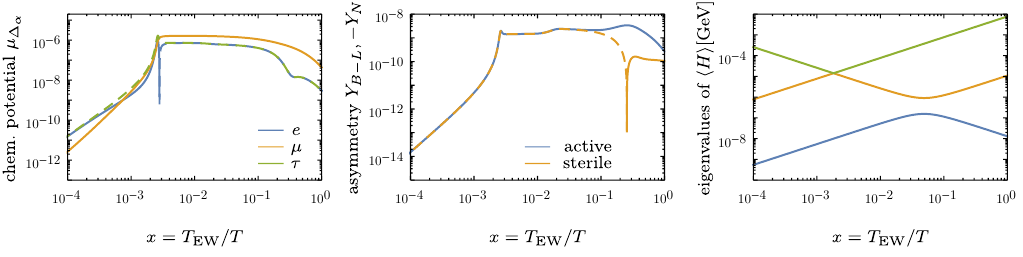
Figure 6 . Benchmark point II). Left: asymmetries in the individual active (cid:13)avours. Center: sum of asymmetries in the active (blue) and sterile (orange) (cid:13)avours. Right: eigenvalues of the e(cid:11)ective Hamiltonian h H i . Continuous (dashed) lines indicate positive (negative) values.